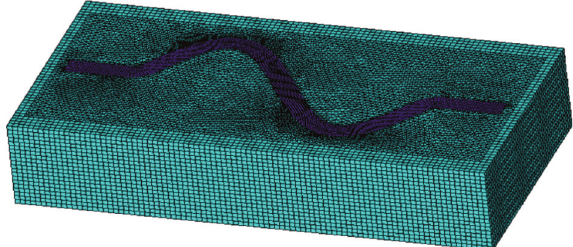
Figure 4: Discrete finite element model (NR � 2).